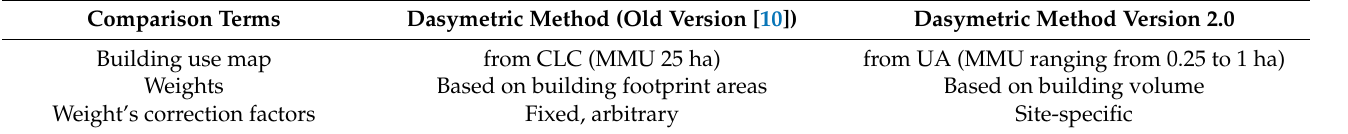
Figure 3. Building use information extracted from Urban Atlas 2012 ( a ) and 2018 ( b ) provided by Copernicus Land Monitoring Services. Background source: Bing Aerial. Table 3. List of novelties introduced with respect to the previous version of the